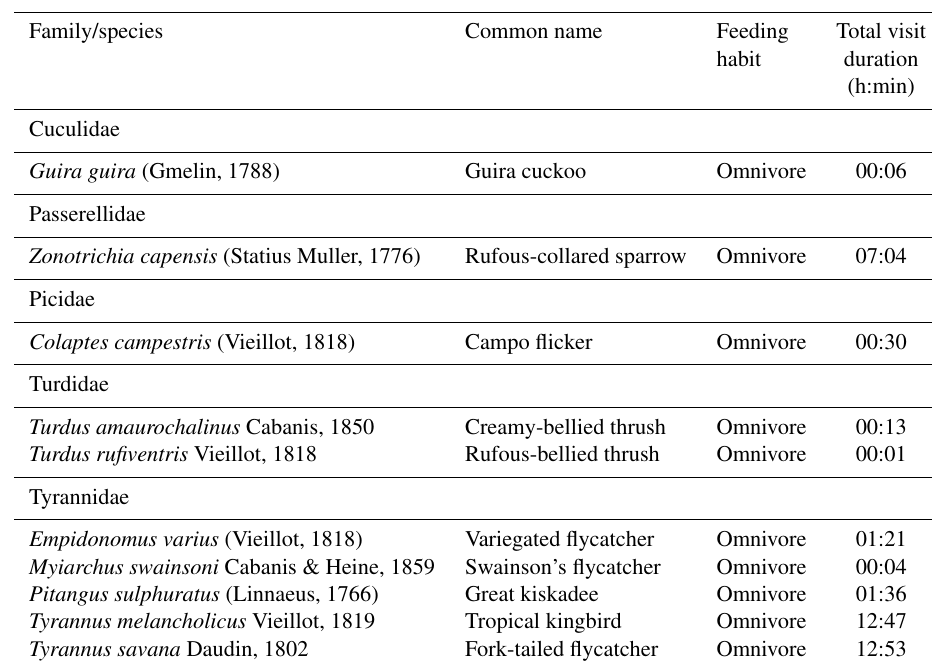
Table 4. Bird species observed using artificial perches that could potentially act as seed dispersers. Family/species Common name